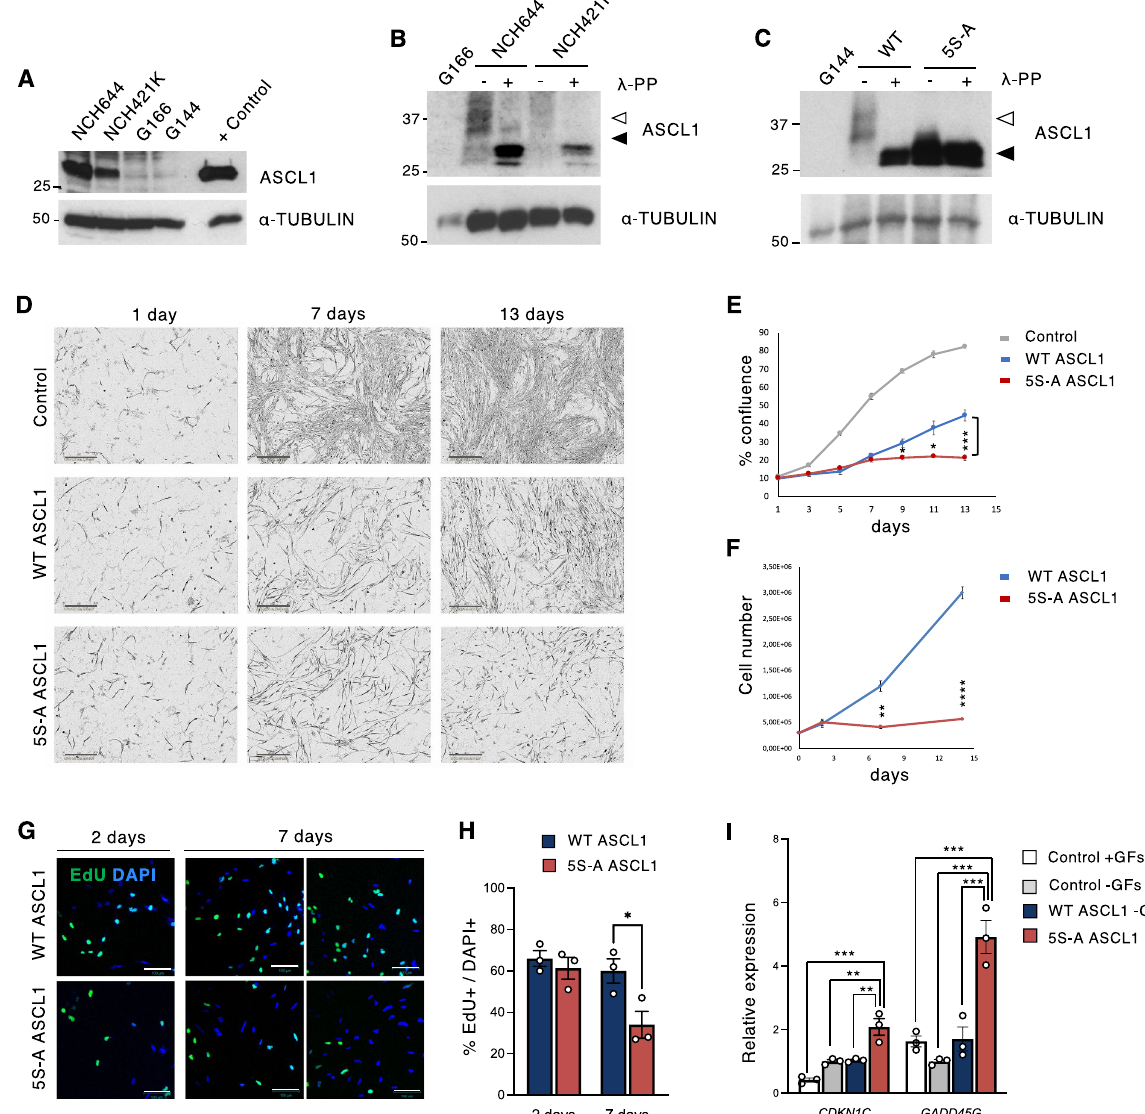
Figure 1. ASCL1 phosphorylation regulates proliferation of human GSCs. ( A ) ASCL1 protein expression in GBM cell lines; positive control is after ASCL1 overexpression. ( B ) Western blot showing endogenous ASCL1 phosphorylation in GBM cells, with and without phosphatase (λ-PP) treatment. ( C ) Overexpression of WT and 5S-A ASCL1 in G144 cells, with and without λ-phosphatase treatment. White arrowheads in B and C indicate phosphorylated ASCL1, while black arrowheads indicate unphosphorylated ASCL1. ( D ) Representative images of G144 cells after growth factor withdrawal and dox-induced WT and 5S-A ASCL1 expression. Scale bars: 300 μm. ( E ) Quantification of cell confluence. Each data point is mean ± SEM. n = 3 independent experiments; one-way ANOVA followed by the Bonferroni post-hoc test; * p < 0.05; *** p < 0.001. All data points from day 3 onwards statistically differ between control and WT ASCL1 and between control and 5S-A ASCL1 ( p < 0.05; not shown). ( F ) Quantification of cell number at 2, 7 and 14 days of ASCL1 induction. Data: mean ± SEM n = 3 independent experiments, t-test; ** p < 0.01; **** p < 0.0001 ( G ) Immunofluorescence showing EdU incorporation. Scale bars: 100 μm. ( H ) Quantification of the % of EdU-positive cells. Data: mean ± SEM n = 3 independent experiments, t-test; * p < 0.05. ( I ) Expression of negative cell cycle regulators in G144 cells after 7 days of ASCL1 induction. Data: mean ± SEM, normalized to TBP . n = 3 independent experiments; one-way ANOVA followed by the Bonferroni post-hoc test; ** p < 0.01; *** p < 0.001. Full length western blots are provided in Supplementary Fig. S1A, B and